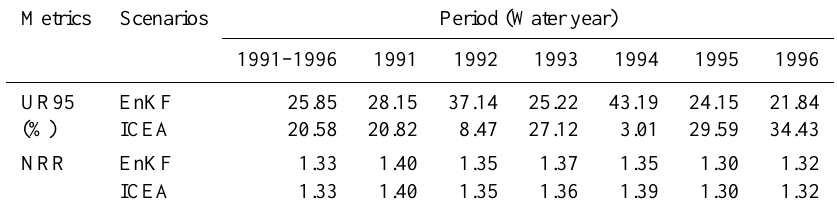
Table 6. Ensemble performance statistics associated with the EnKF and ICEA scenarios during the prediction